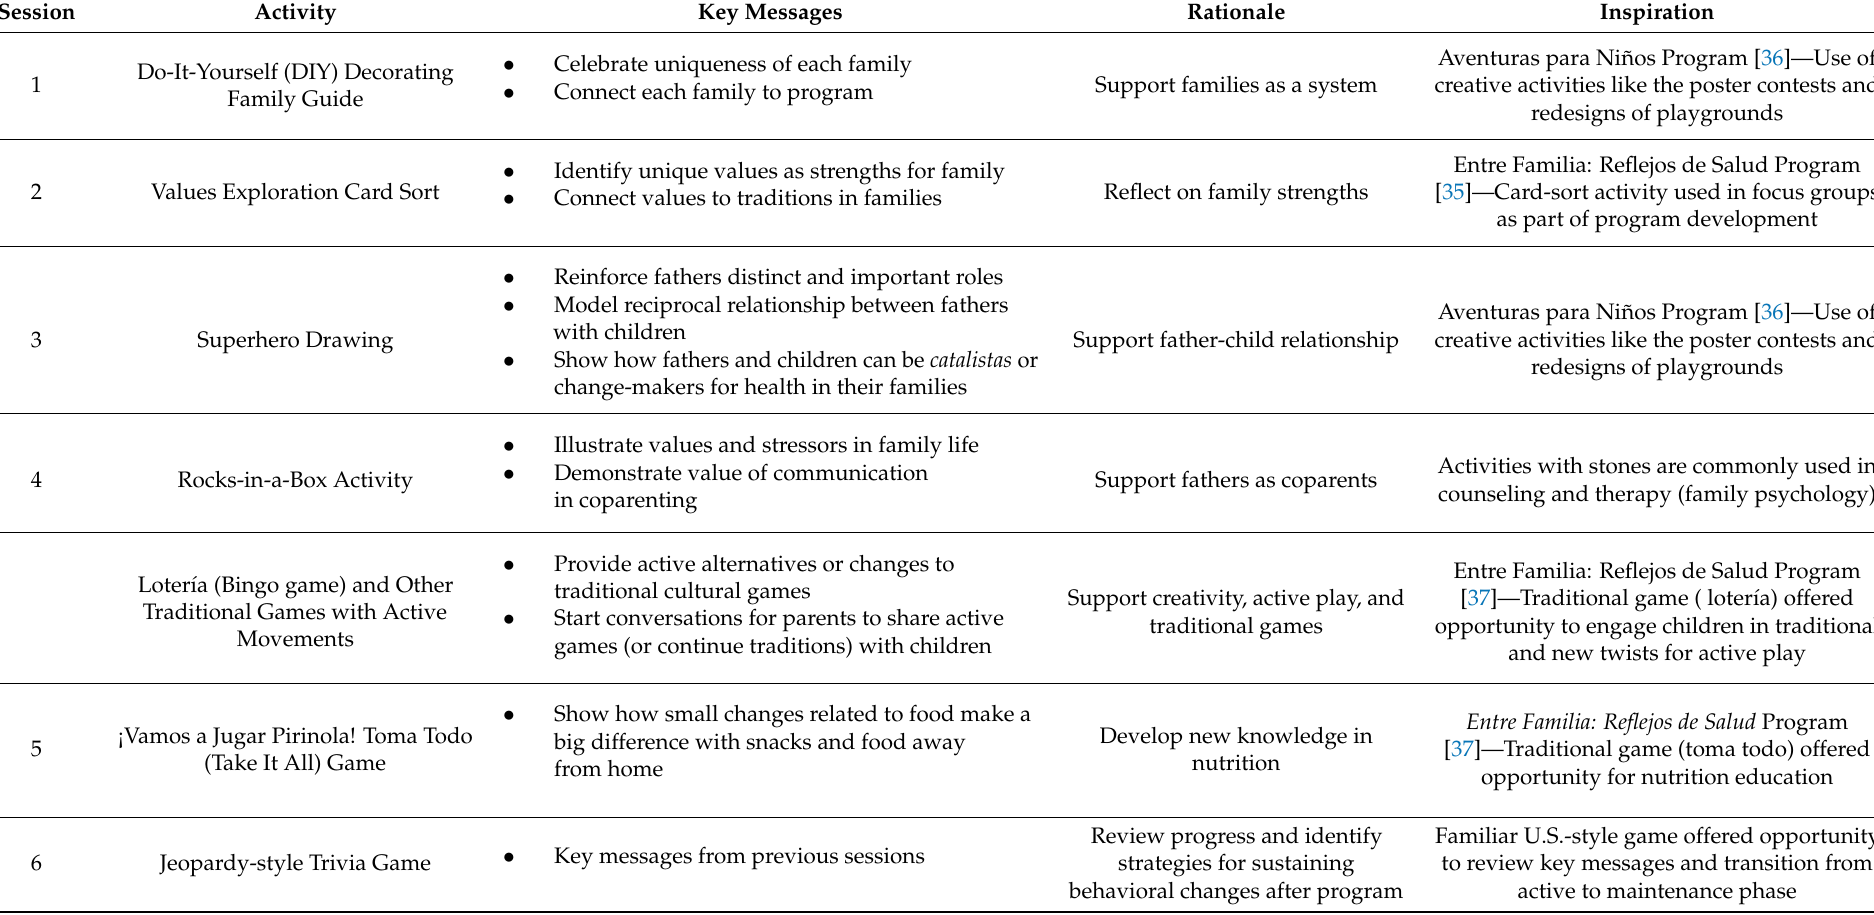
Table 4. Activities and key messages for the interactive